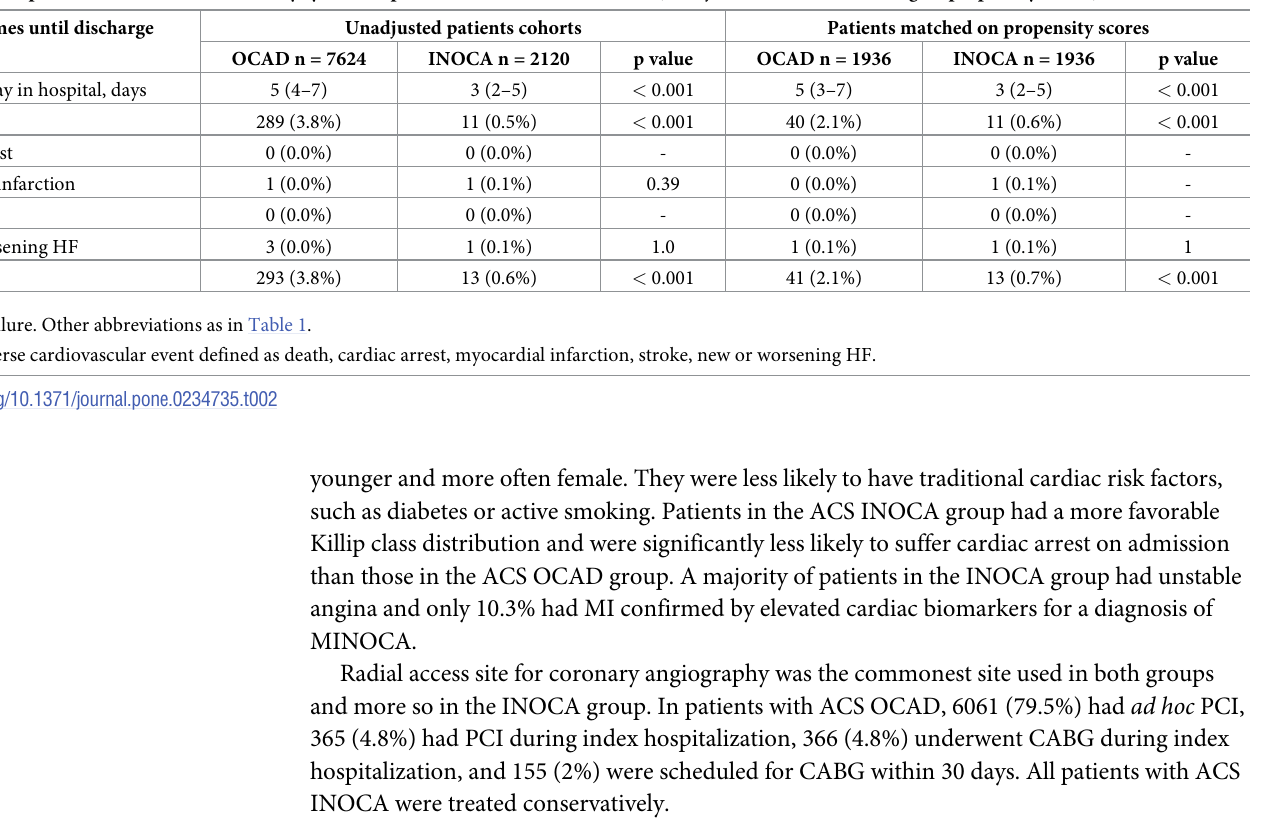
Table 2. In-hospital outcomes of acute coronary syndrome patients with OAD and INOCA (unadjusted and after matching on propensity scores).